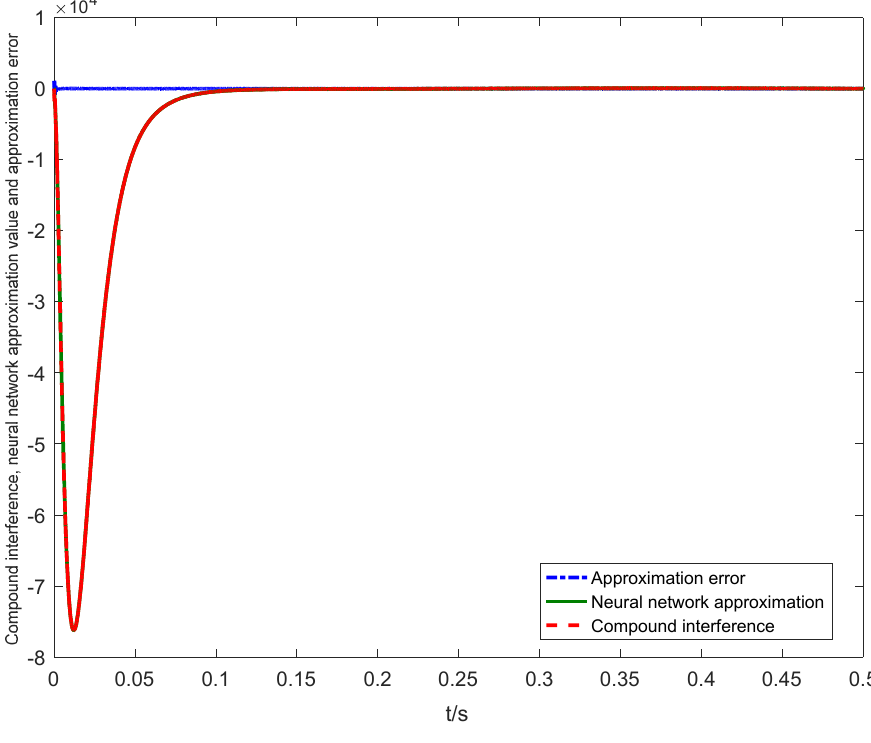
Figure 10. System disturbance term and output and approximation error of neural network ap ‐ proximator